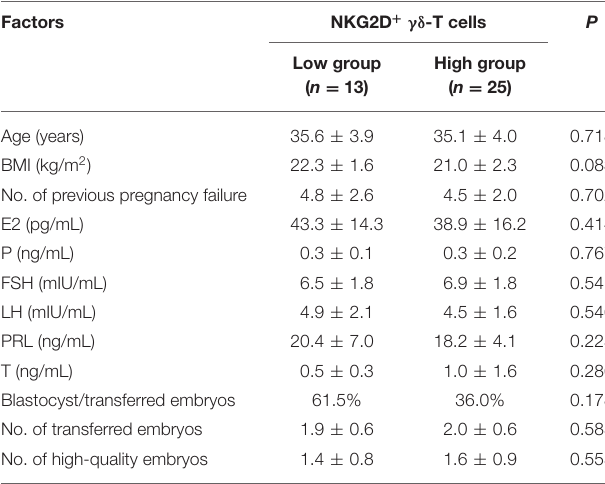
TABLE 3 | Clinical characteristics of uRIF patients categorized based on the cut-off value of percentage of NKG2D + γδ -T cells in lymphocytes. Factors